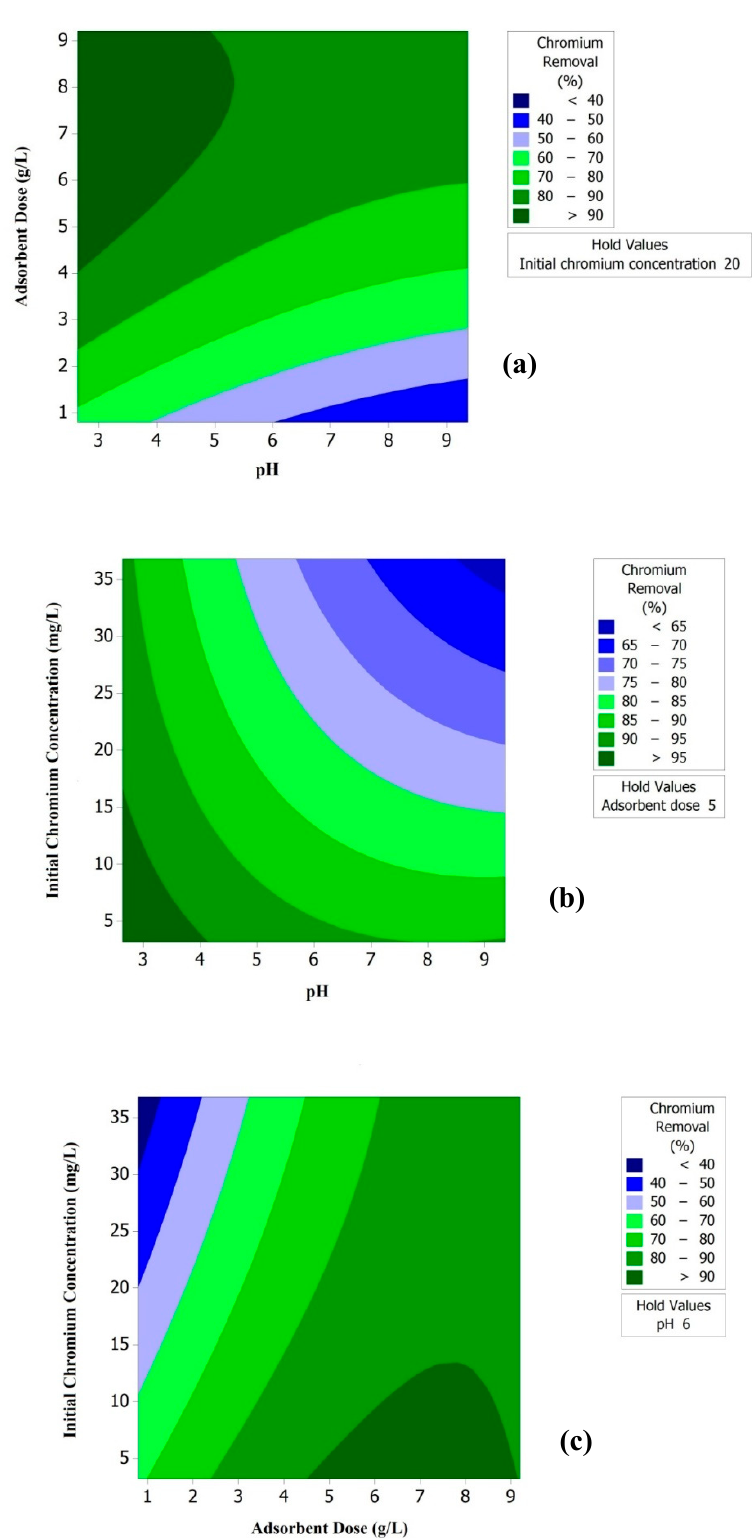
Figure 4. Response contour plots showing: ( a ) the e ff ects of pH (X 1 ), adsorbent dose (X 2 ), and their interaction on chromium RE, with constant initial chromium concentration (X 3 ); ( b ) the e ff ects of X 1 , X 3 , and their interaction on chromium RE (%); ( c ) the e ff ects of X 2 , X 3 , and their interaction on chromium RE (%).